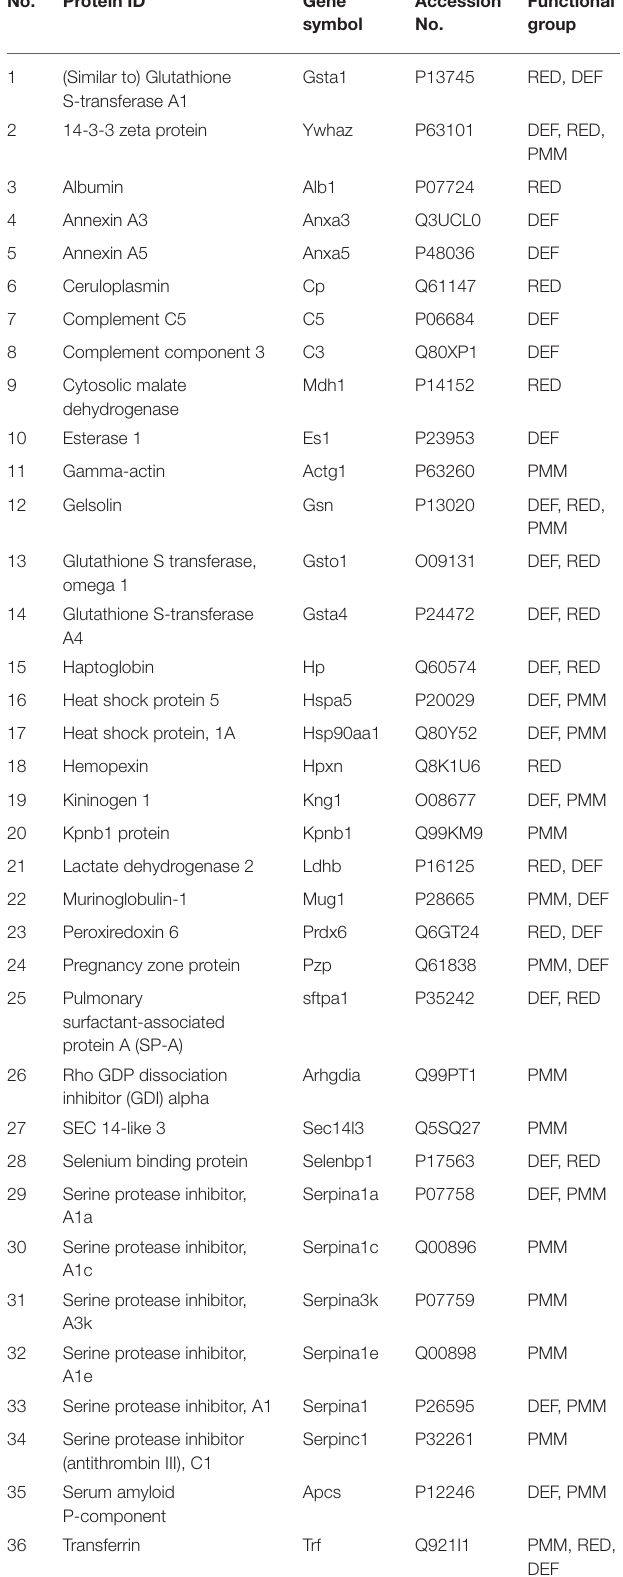
TABLE 3 | List of identified proteins.